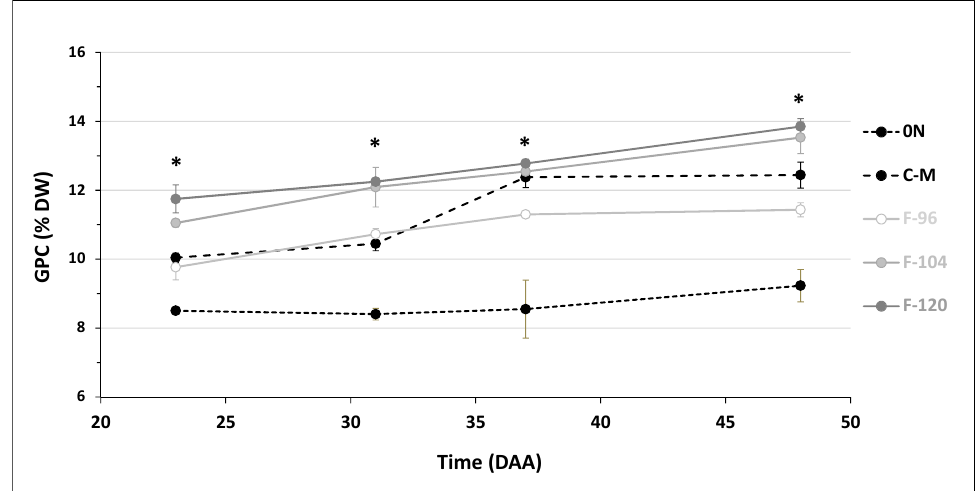
Figure 1. Dynamics of grain protein accumulation (GPC) (% ± S.E.; n = 3) in wheat over time (DAA, days after anthesis) under different foliar N fertilization treatments with urea (season 2019–2020) vs. control C-M. Asterisk (*): statistical significant differences among treatments (Newman–Keuls test, p ≤ 0.05).